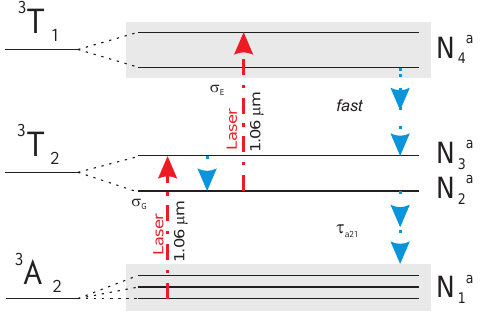
levels and absorption transitions in the Cr:YAG Q-switcher is presented in Fig. 3. Absorption of laser radiation from ground and excited states are usu- ally realized during the PQS process.